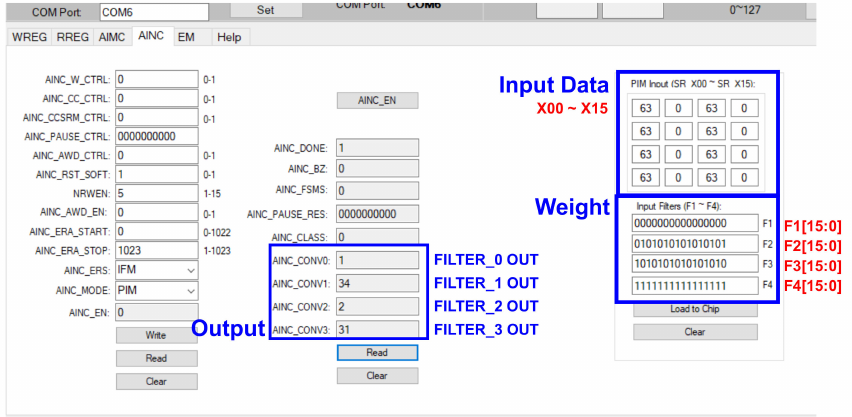
Figure 21. Measurement results of filter output.